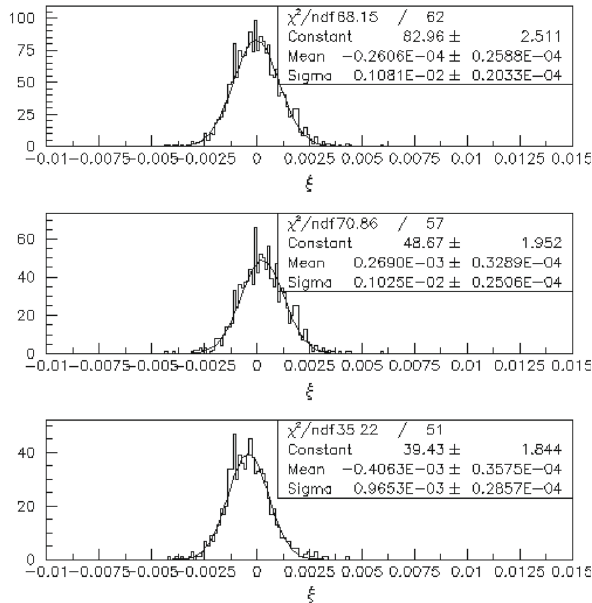
Fig. 4 Distribution of ξ( t ) for rigidity 0.4–0.65 GV. On the top the gaussiandistributionforall ξ( t ) with1865dailyaverages(0 ◦ < Φ EJ < 360 ◦ ), in the middle the distribution with 1069 daily averages having 129 ◦ − 90 ◦ < Φ EJ < 129 ◦ + 90 ◦ , on the bottom the distribution with 796 daily averages having Φ EJ outside the above angle interval